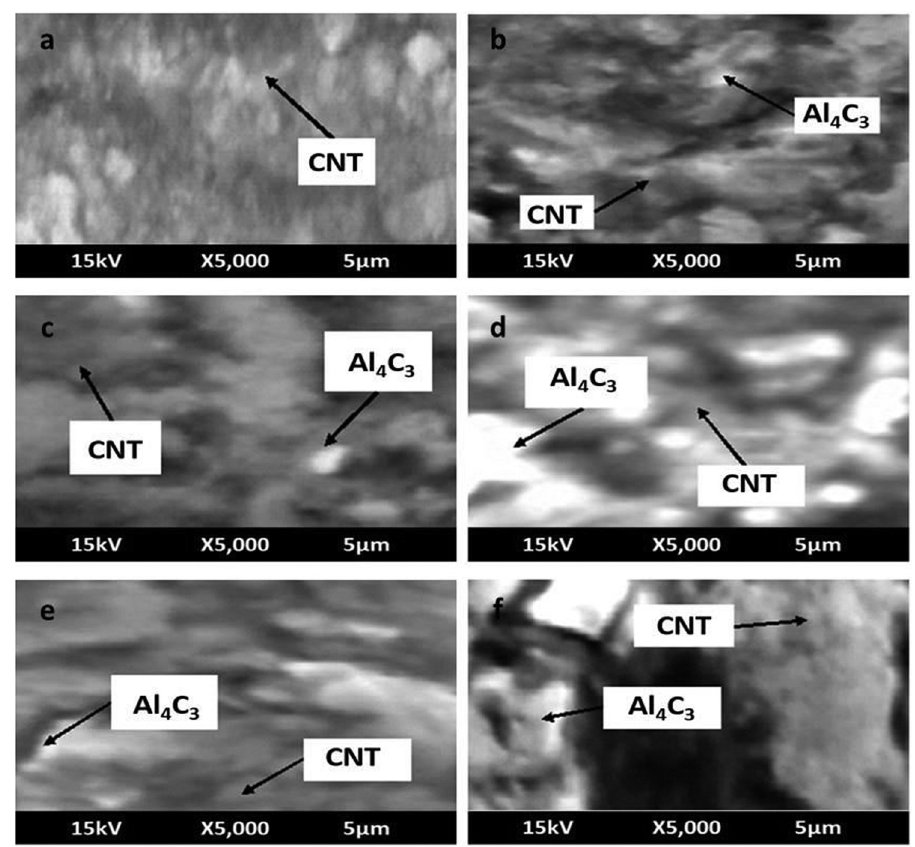
Figure 13: SEM of heat - treated ( a ) 0%, ( b ) 0.1%, ( c ) 0.2%, ( d ) 0.3%, ( e ) 0.4%, and ( f ) 0.5% MWCNT - reinforced Al – Cu – Mg – T351